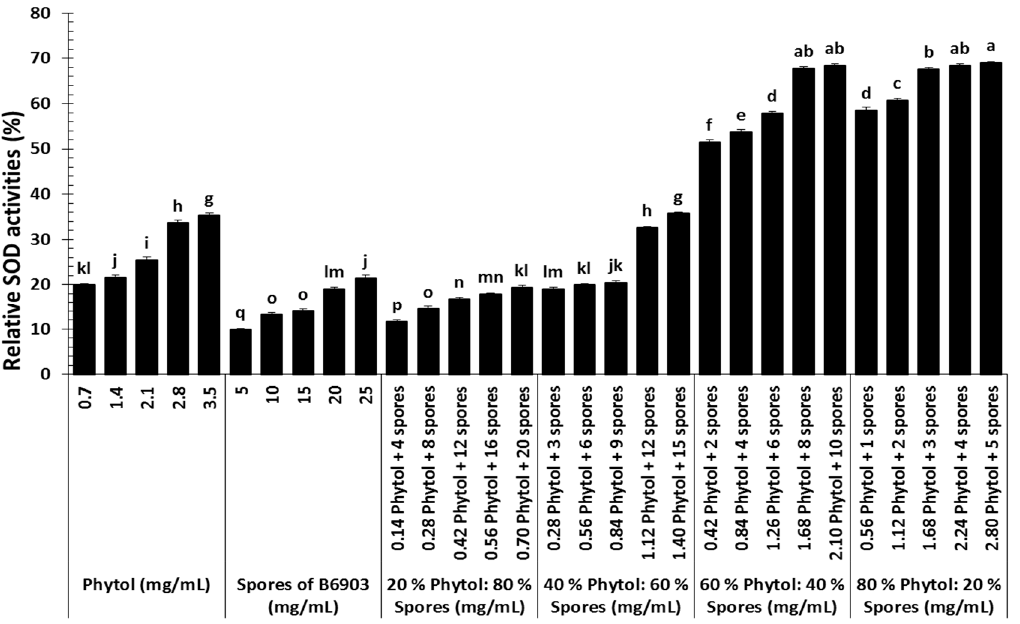
Figure 4. Superoxide dismutase (SOD) activities (%) of Oligonychus afrasiaticus (McGregor) fed on date palm leaf disks treated with different combinations of phytol and spores of Beauveria bassiana B6903 relative to control. Bars (means ± SE) followed by different letter(s) are significantly different (Fisher’s LSD test, α = 0.05).